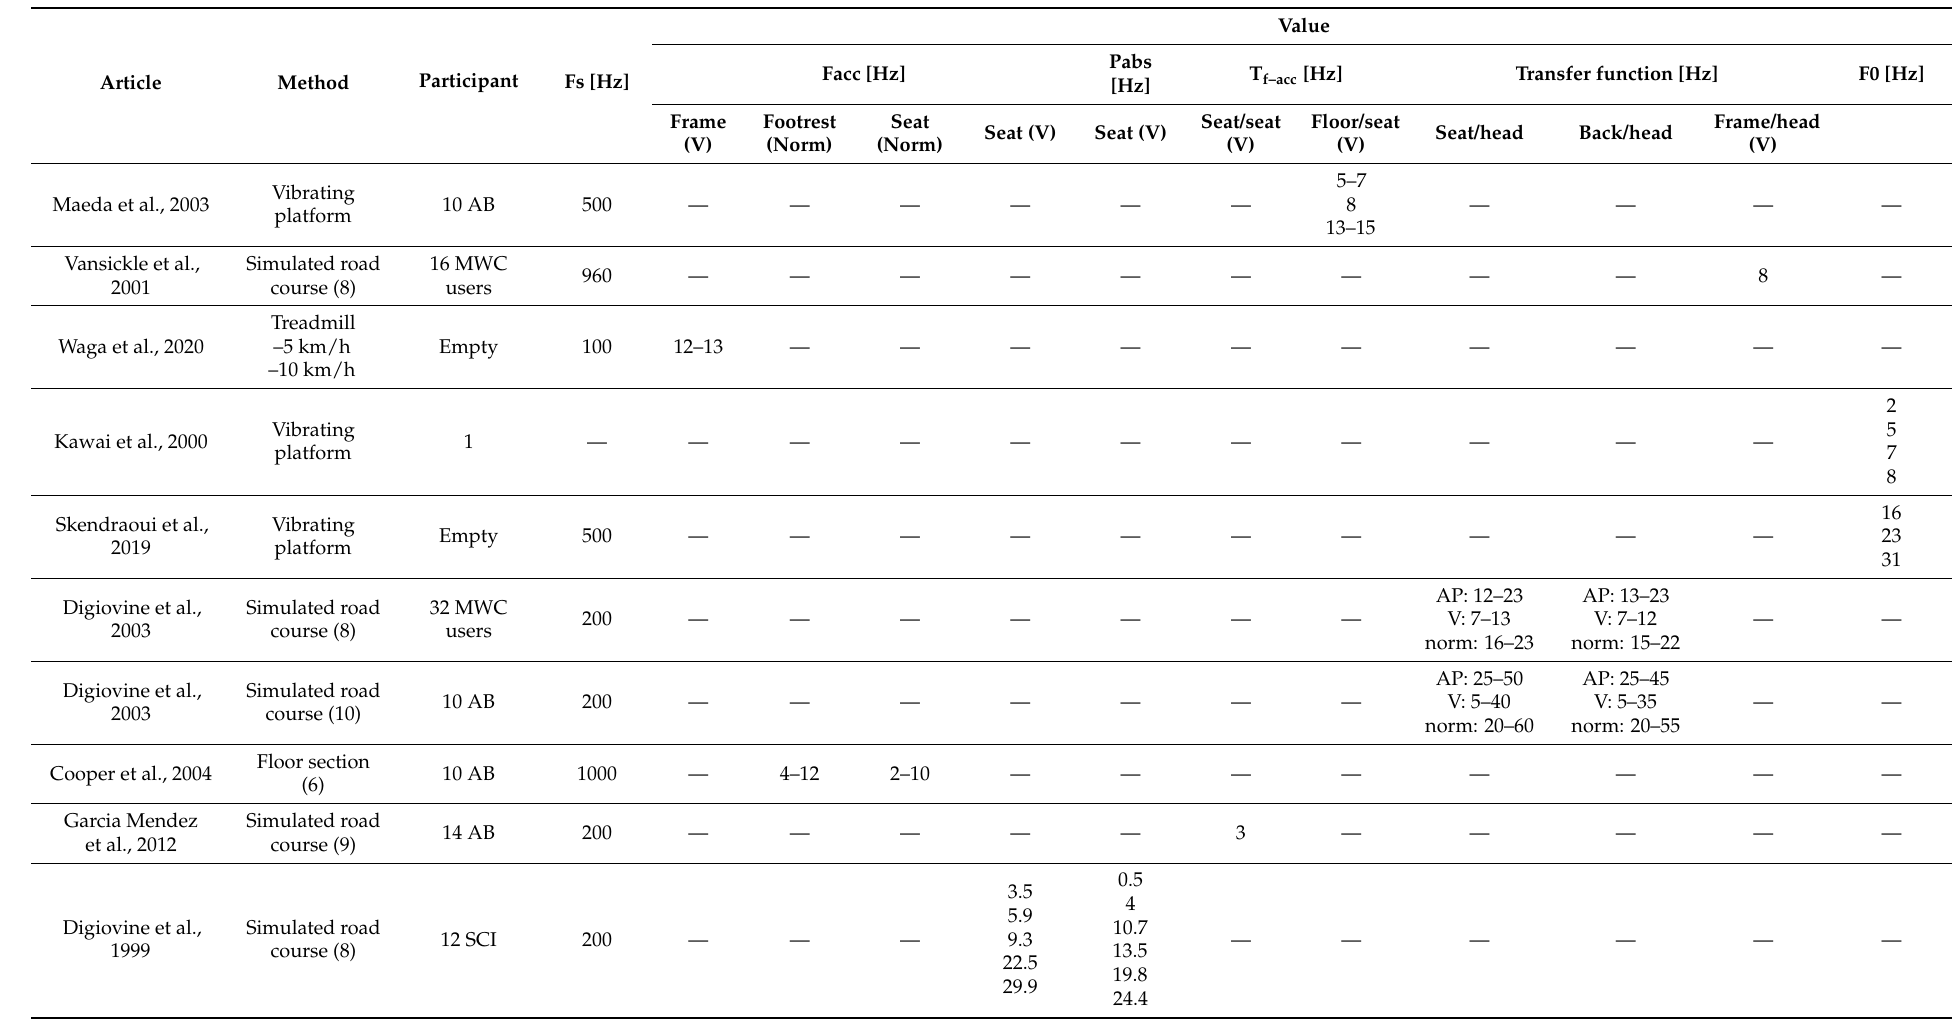
Table 4. Summary table of reviewed studies regarding vibration frequency during MWC